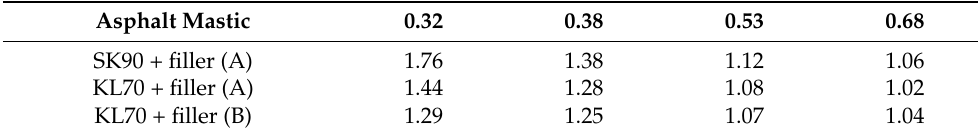
Table 2. C value of different asphalt and filler. Asphalt